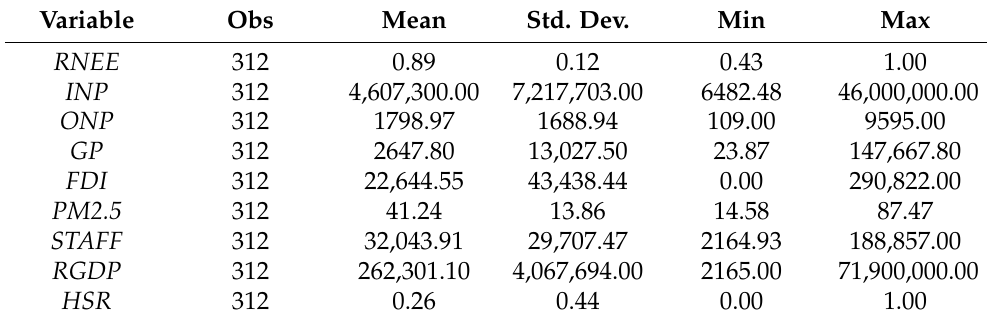
Table 1. Variable Description